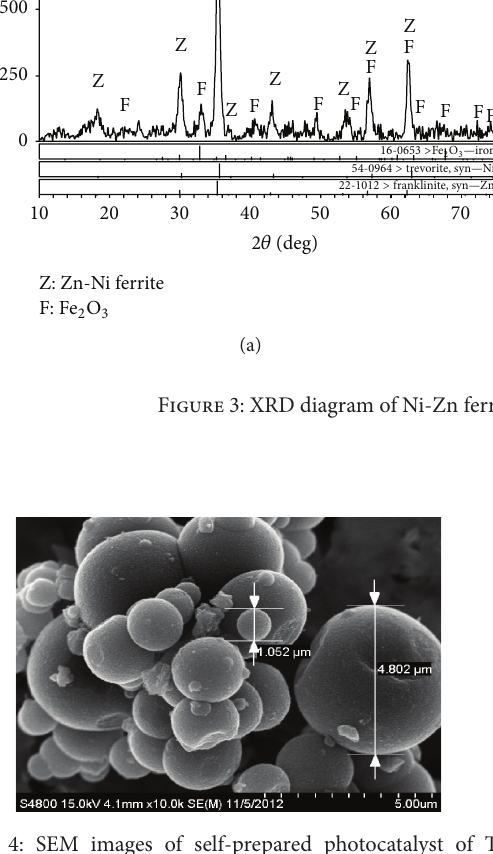
Figure 4: SEM images of self-prepared photocatalyst of TiO 2 ( ×